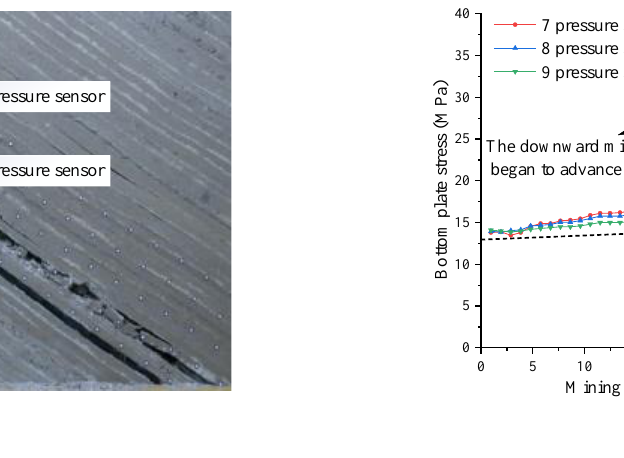
Figure 10. Variation of floor stress during upper coal mining. ( a ) Overlying rock displacement of upper coal mining; ( b ) stress variation diagram of bottom plate.